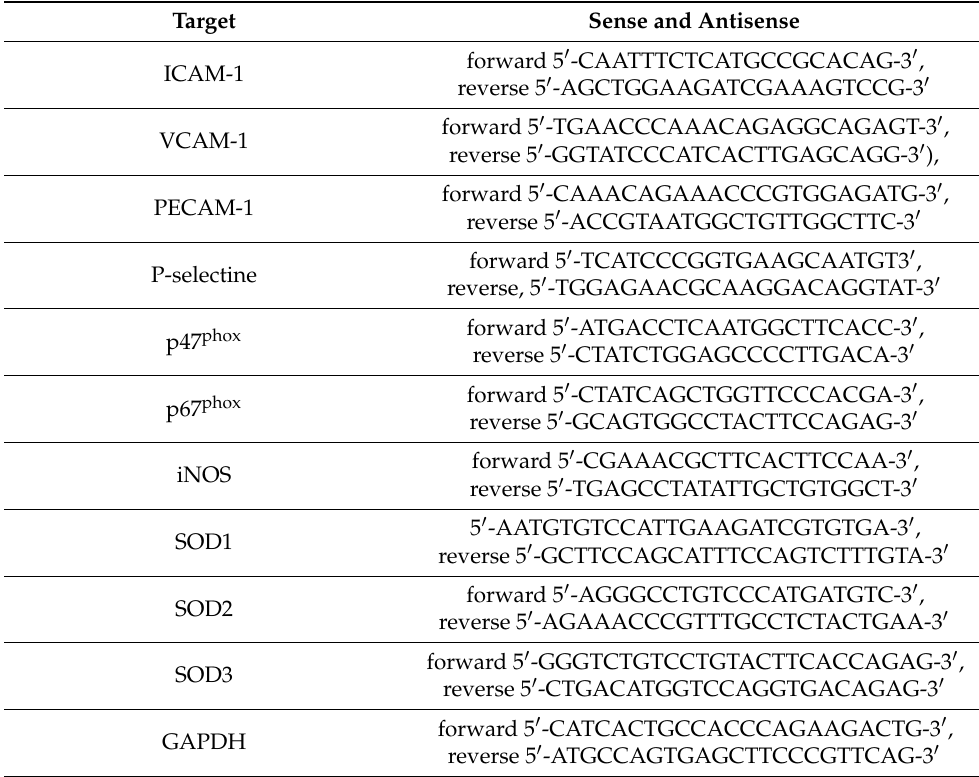
Table 1. Primers used for Real-Time